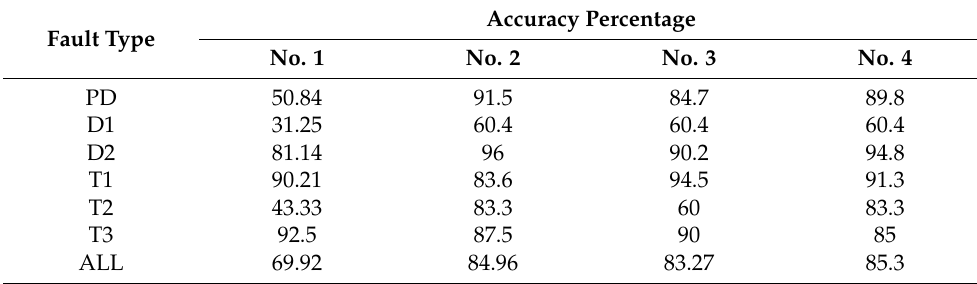
Table 6. Accuracy percentages of the four proposed